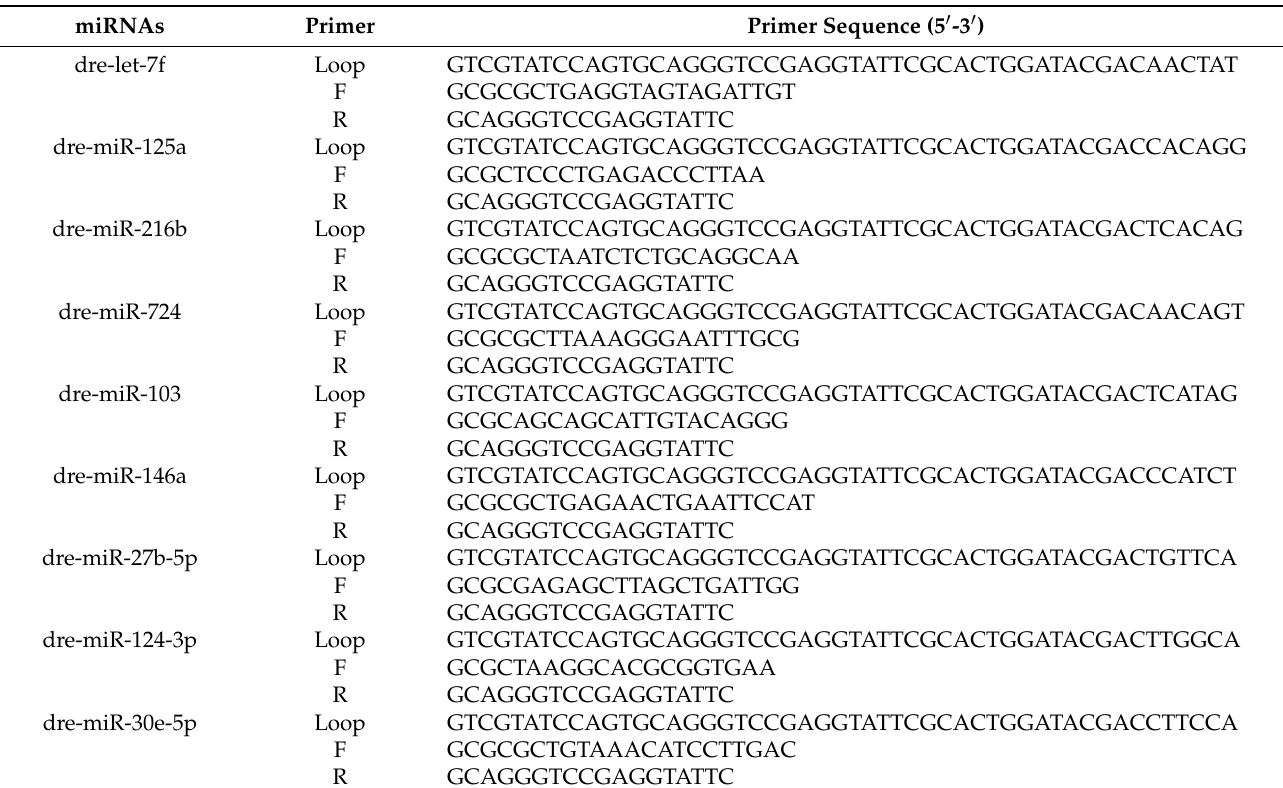
Table 1. Primers used in qRT-PCR for miRNA expression